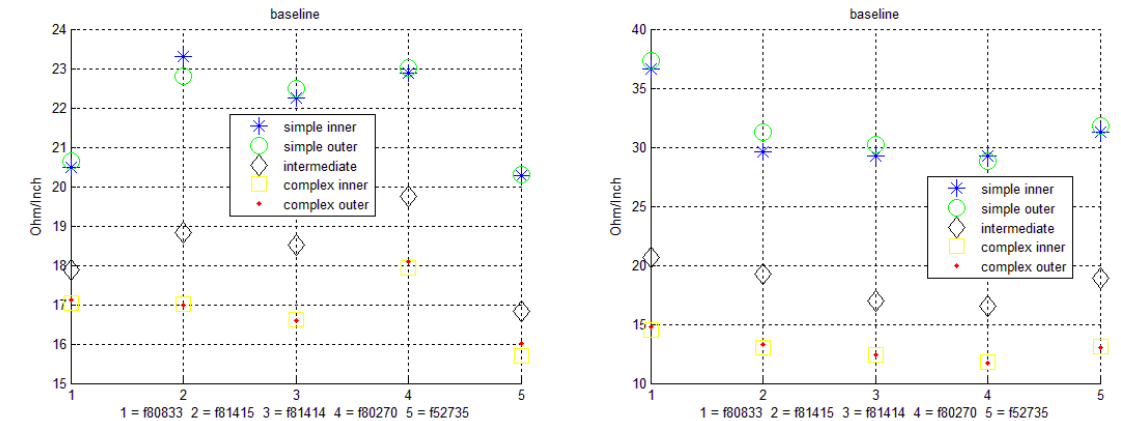
Figure 20. Baseline resistance normalized by fold length: ( left ) un-insulated case; ( right ) insulated